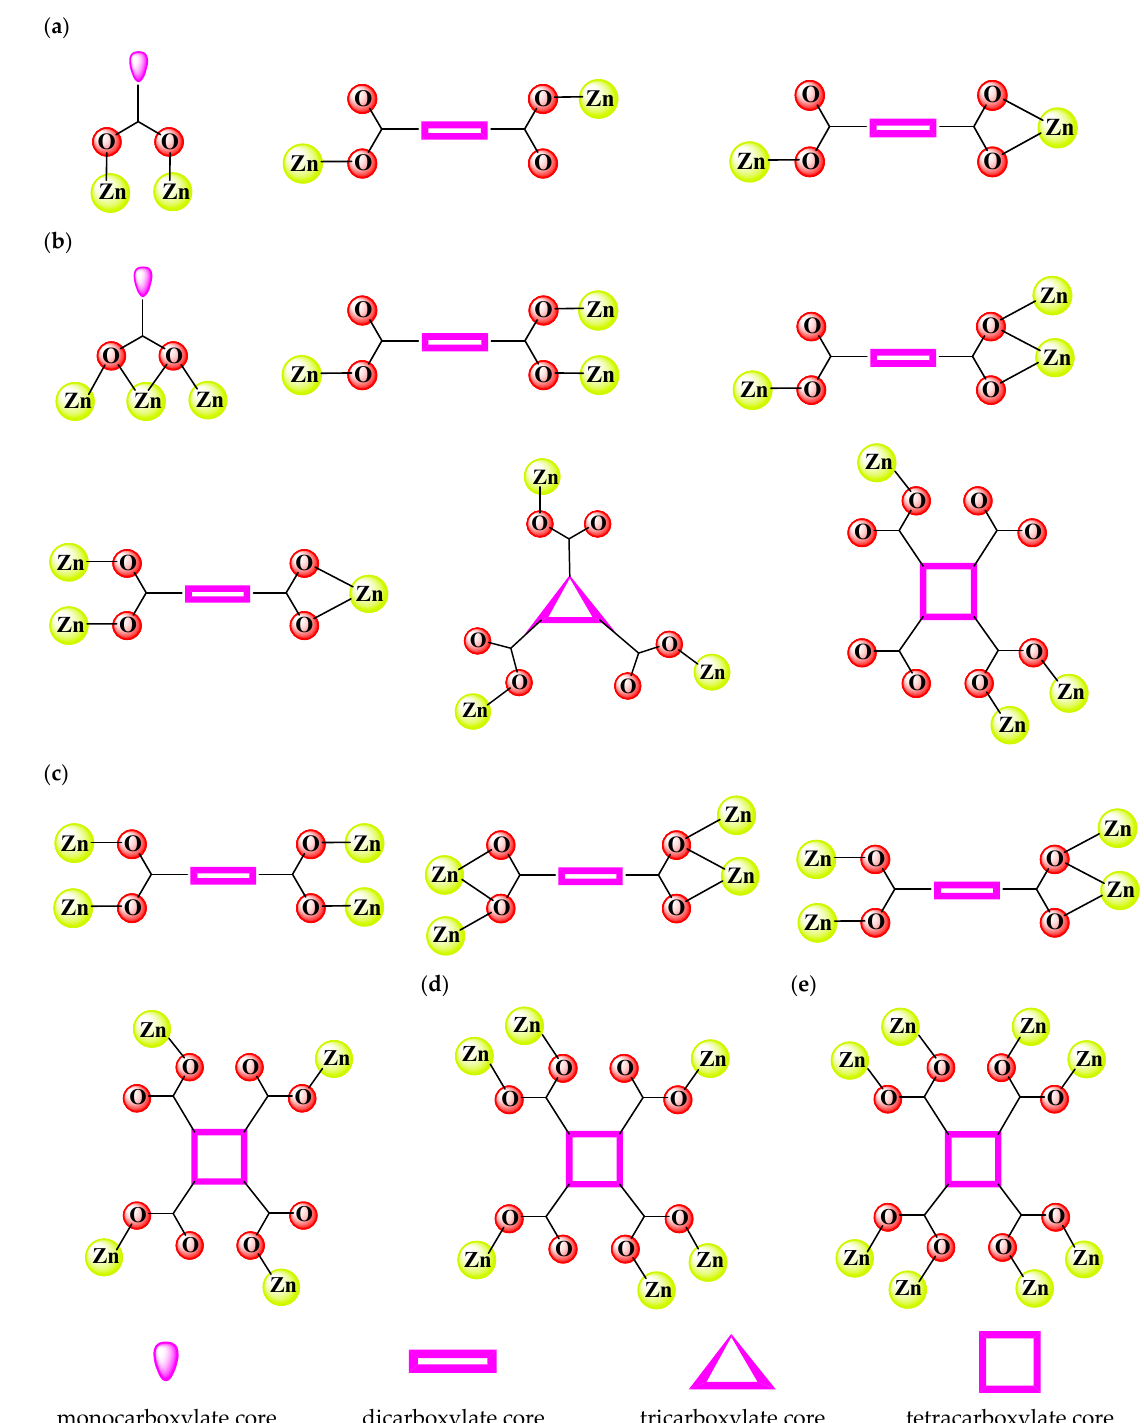
Figure 1. Coordination modes adopted by carboxylate groups in Zn(II) carboxylate-based coordi- nation polymers: ( a ) bridge between two Zn(II) ions, ( b ) bridge between three Zn(II) ions, ( c ) bridge between four Zn(II) ions, ( d ) bridge between six Zn(II) ions, and ( e ) bridge between eight Zn(II) ions.